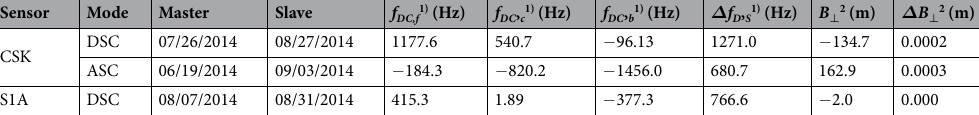
CSK satellite along with a single pair of descending images from the satellite S1A. The descending CSK pair cov- ers potential postseismic deformation over 3 days, while the ascending CSK and descending S1A pairs cover 10 and 7 days, respectively. We also collected additional CSK data in a descending orbit in order to match the repeat pass timing of the S1A pair, but did not use the additional data for analysis as we found insignificant deformation signals from the 3-day postseismic interferogram; the pair of images caused an increase in unwanted signal noise rather than meaningfully coherent signals. Thus, we only used the initial three coseismic pairs to retrieve the 3D components of surface deformation by combining the InSAR and MAI measurements from all pairs. The major data-processing difference between CSK and S1A SAR data is the generation of the sub-aperture single-look complex (SLC) in the MAI processing scheme. We initiated MAI processing by using raw SAR signals for both descending and ascending CSK data. Four SLC images, composed of both forward- and backward-looking SLC images from the master and slave SAR data, were generated by controlling the Doppler Centroids and processing bandwidth ( PBW ) for sub-aperture images according to the MAI processor 8 . On the other hand, we obtained SLC images from the S1A SAR system because they were the only available data for- mat from the data distribution centre. The MAI processing for the SLC data includes azimuth common-band filtering between the master and slave SLC images and beam-splitting for the purpose of dividing forward- and backward-looking spectrums. After separating out two forward-looking and two backward-looking SLC images from a single InSAR pair, both forward- and backward-looking interferograms were independently generated. MAI interferograms were then computed using complex conjugate multiplication between sub-aperture interferograms for each of the CSK and S1A SAR data, as described by Jung et al . 8 . Along-track displacements ( Δ x ) using the MAI method can be